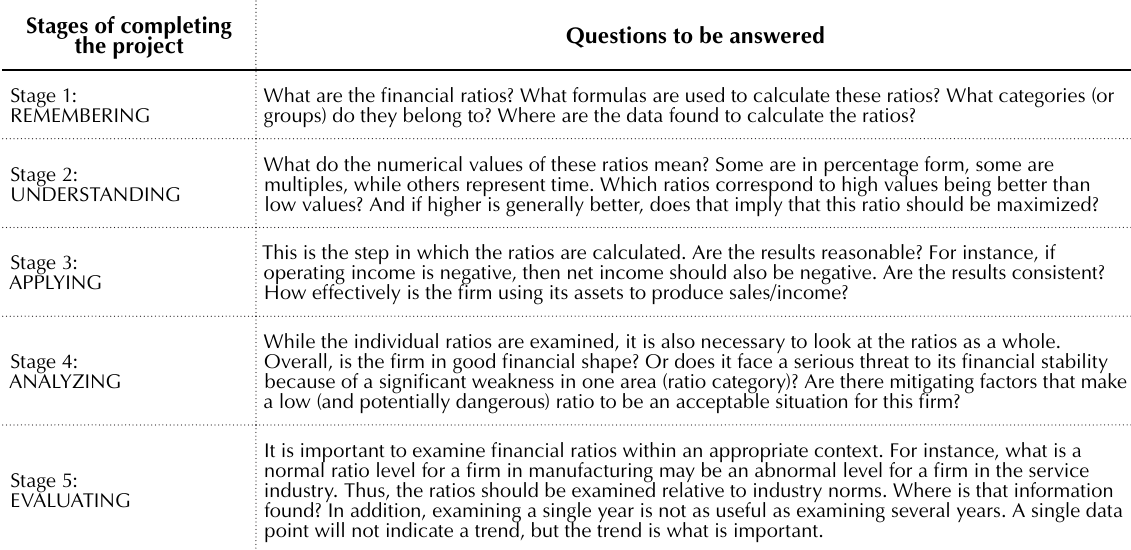
Source: Financial Management, U.S. Coast Guard Academy. Questions to be